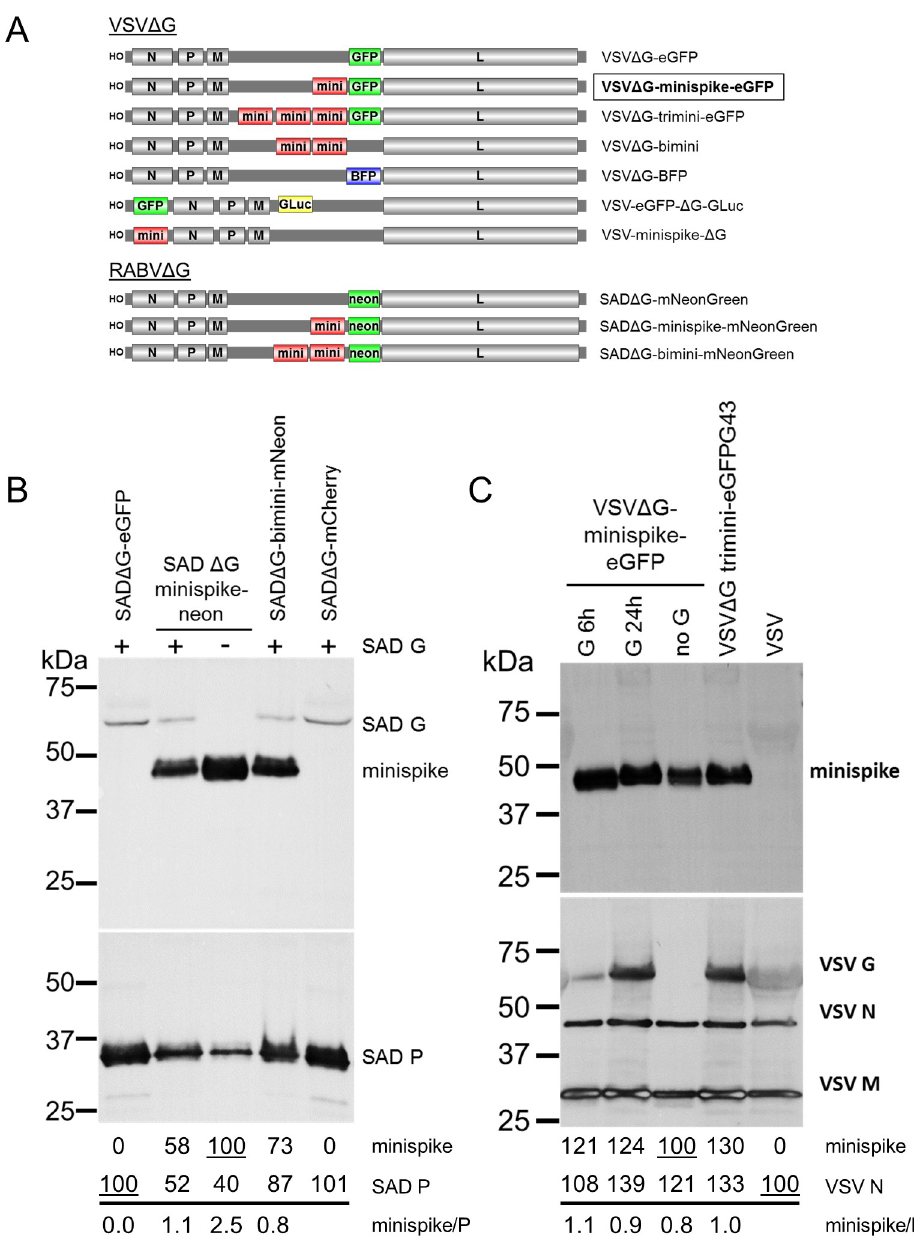
Fig 2. Characterization of minispike rhabdoviruses. (A) Schematic of VSV Δ G and RABV Δ G constructs used here. (B) Incorporation of minispike in RABV SAD envelopes. Cell-free SAD Δ G-virus particles as indicated were generated in HEK293T cells in the absence or presence of RABV SAD G. Lanes were loaded with 1 million infectious units each, blots were incubated with HCA-5 recognizing the cytoplasmic tails of minispike and SAD G (upper panel) and anti- RABV P serum to determine virus load (lower panel). Quantification of band intensities indicates competition of minispike and SAD G for incorporation into virions. (C) Incorporation of minispike in VSV envelopes. Cell-free minispike-encoding VSV Δ G viruses were generated in HEK293T cells expressing VSV G from transfected pCAGGS-VSV G for 6 or 24 hrs prior to infection, or in stable BHK-G43 cells (VSV Δ G-trimini-eGFP) induced at the time of infection were purified by ultracentrifugation. Lanes were loaded with 1 million infectious units of G- containing infectious viruses, and the same volume of non-infectious viruses (no G). Blots were incubated with serum HCA-5 recognizing the RABV G-derived C-tail of the minispike (upper panel) or with anti-VSV serum recognizing viral N, M, and G proteins (lower panel). Note that G24h preparation contains G vesicles (see Fig 3).